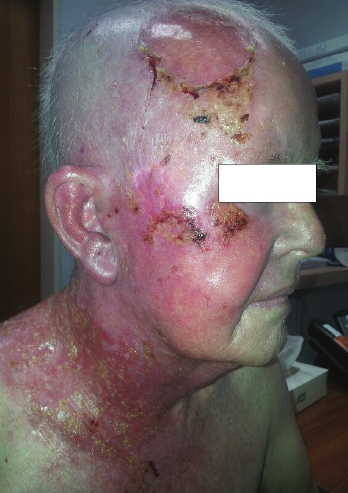
Figure 2: Clinical photograph taken in week five of treatment showing confluent wet desquamation.